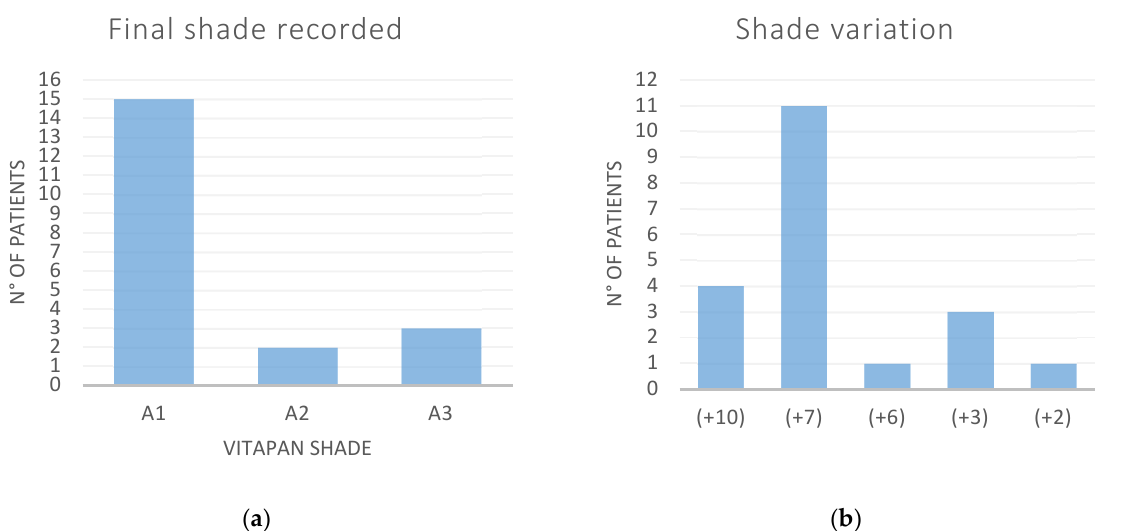
Figure 6. Results of dental-whitening treatments recorded for the 20 patients participating in the study: final shade recorded ( a ) and shade variation ( b ).